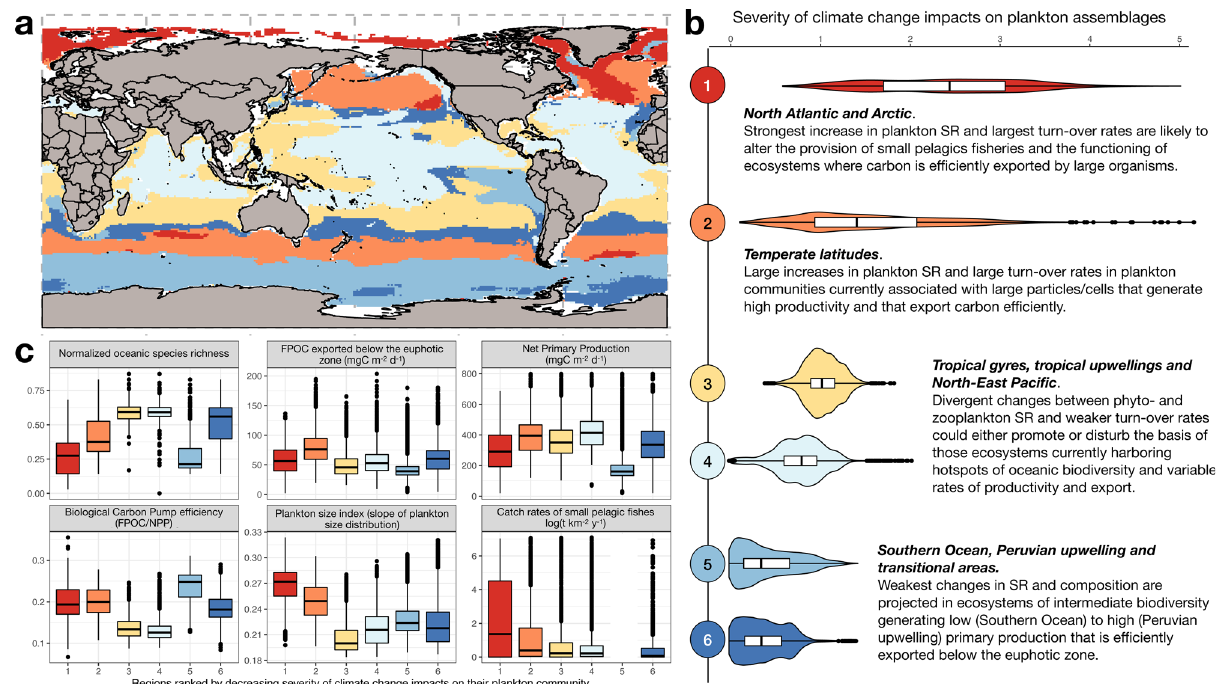
Fig. 4 Overlap analysis between climate change impacts and marine ecosystem services provision. Distribution of a the ocean regions de fi ned and b ranked according to the median severity index of climate change impacts on their plankton community and c how they overlap with the contemporary provisioning of marine ecosystem services. The regions were de fi ned by clustering every raster cell of the global ocean based on their average projected difference in annual phyto- and zooplankton species richness, phyto- and zooplankton species true turnover and total plankton turnover. Six proxy variables linked to marine ecosystem services across the six regions were considered: Oceanic megafauna biodiversity (SR) 13 (normalized species richness), mean annual catch rates of small (<30 cm) pelagic fi shes (log(tonskm − 2 yr − 1 )) 34 , annual net primary production (NPP; mgC m − 2 d − 1 ) 35 , the corresponding fraction of particulate organic carbon exported below the euphotic zone (FPOC; mgC m − 2 d − 1 ) and the corresponding ef fi ciency of the production exported (FPOC/NPP), and an index of mean annual plankton size 36 . b also summarizes how the changes in plankton richness and composition might impact the marine ecosystem services shown in c . More details are provided in Supplementary Note 2. The lower, middle, and upper boundaries of the boxplots shown in b and d correspond to the 25th, 50th, and 75th percentiles. The lower and upper whiskers extend from the hinges to the lowest or largest v grid cells alue no further than 1.5*IQR (interquartile range) from the lower and upper hinges. N = 35,023 grid cells for the total sample size ( N region1 = 2344;